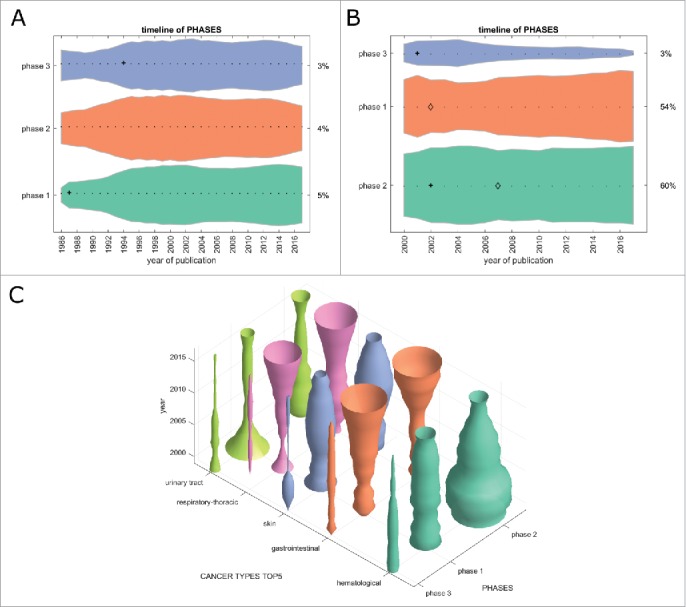
Clinical trial phases. This Fig. shows the development of clinical trials in phase 1/2/3 over time. (A) PubMed articles matching any clinical phase. Only a fraction of PubMed listed articles can be matched to a clinical phase and the proportions between the phases have not changed significantly in the last 20 years. (B) Clinical trials matching any clinical phase, ordered by group size, from bottom to top: phase 2, phase 1, phase 3. Some trials could be matched to multiple phases so that the percentages in 2017 do not necessarily add up to 100%. Phase 2 trials are most abundant and phase 1 trials are slowly growing, albeit not significantly. (C) In stark contrast to the slow overall growth dynamic of clinical trials in the above panels, this panel shows marked changes in clinical trials per cancer entity over time. In gastrointestinal cancer and respiratory-thoracic cancers, phase 1 and 2 trials are currently showing pronounced increase. (A+B) + significant rise of growth rate within one year (anomaly >95%), ◊ significant decrease of one-year growth rate (anomaly < 5%).